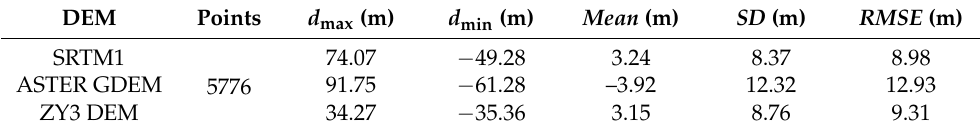
Table 3. Statistics of the vertical error values for different DEMs in the Qianhe Basin. DEM Points d max (m) d min (m) Mean (m) SD (m) RMSE (m) SRTM1 74.07 ASTER GDEM 5776